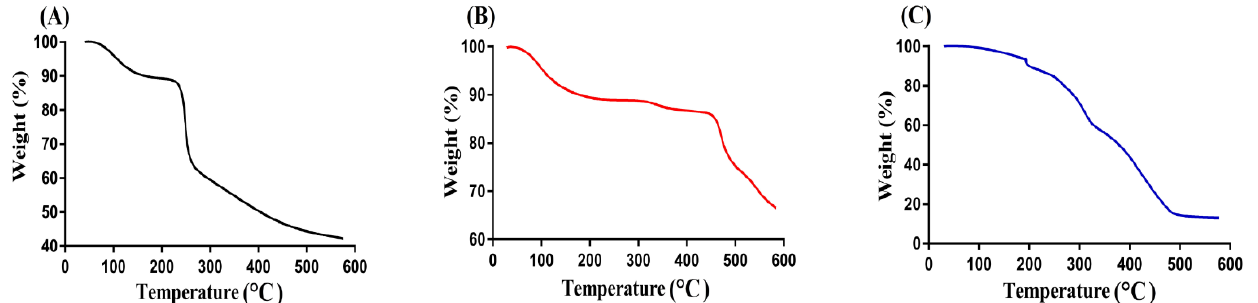
Figure 6. TGA thermogram of ( A ) Cs, ( B ) Sps, and ( C ) Cs/SpsCpAca